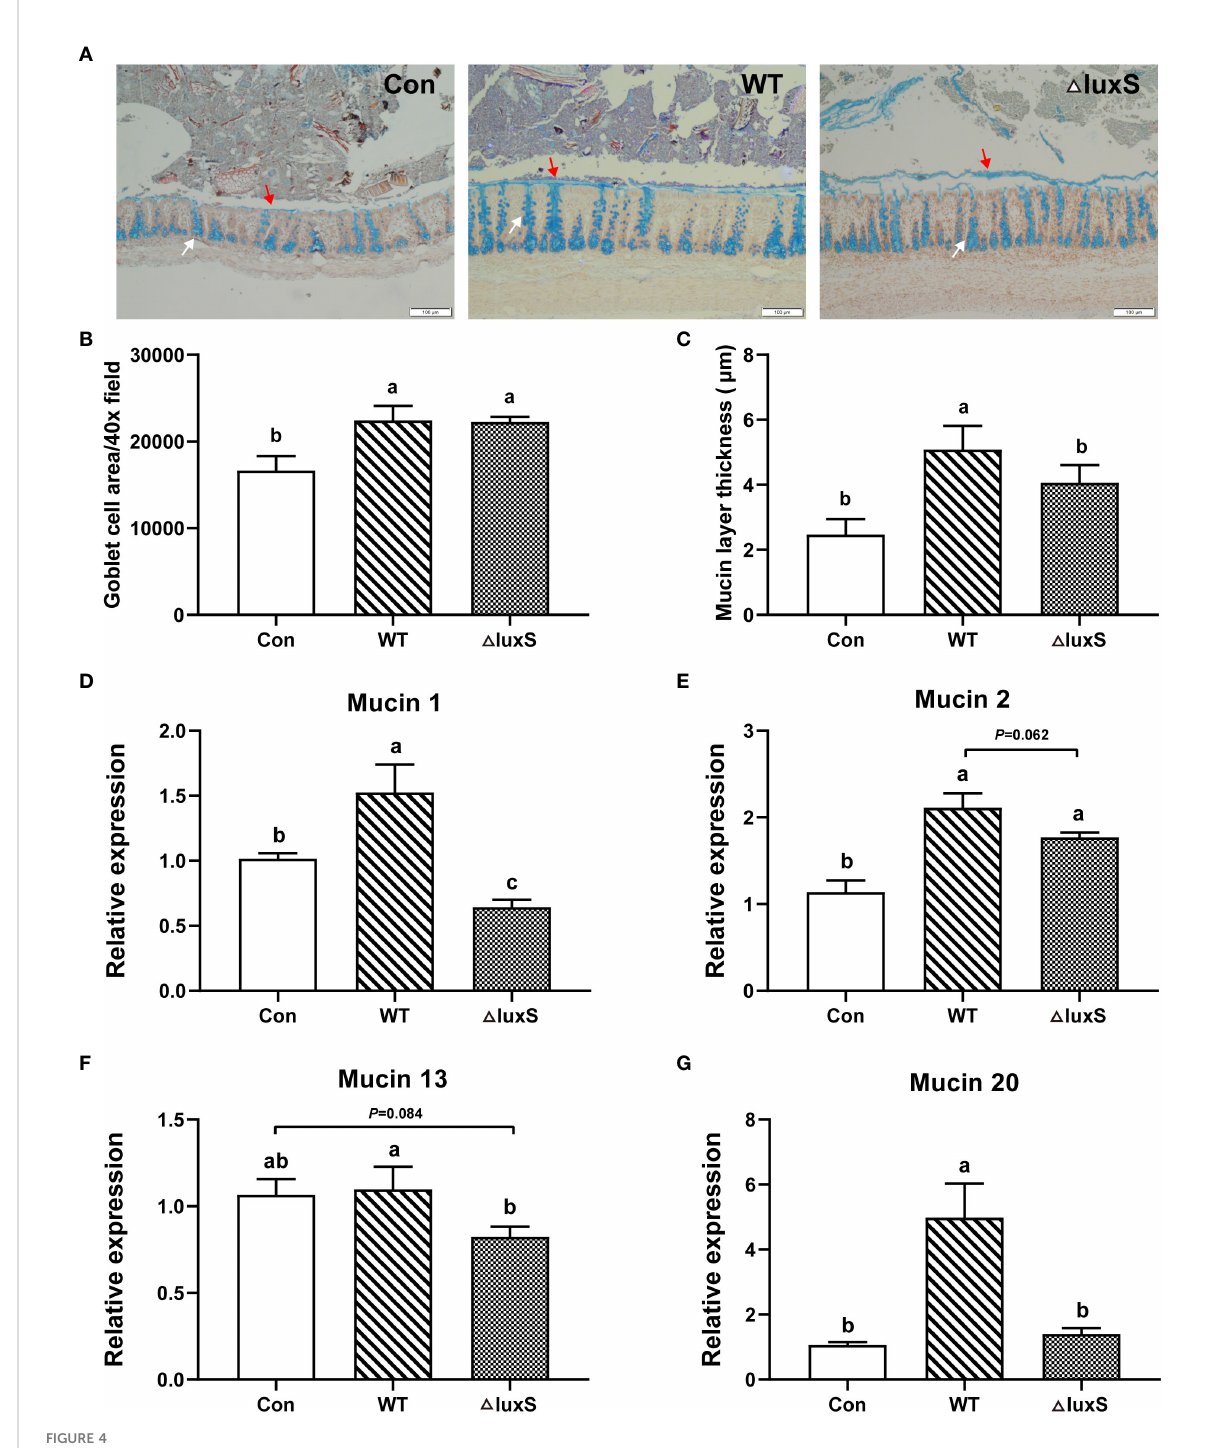
FIGURE 4 Intestinal chemical barrier functions in weaned piglets. (A) Alcian blue staining of colon (100 m m). (B) Goblet cell area. (C) Mucin layer thickness. Ten fi elds of view were randomly selected for each sample for statistics. Red arrows point to the mucus layer and white arrows point to goblet cells. (D-G) The relative mRNA expression of colonic mucins. GAPDH was used as an internal reference. Each PCR reaction was performed in three technical replicates across six biological replicates. WT and D luxS groups were orally inoculated with 2 mL of LGG wild strain and luxS mutant strain, respectively, for 3 weeks before weaning on day 21. Con group was orally inoculated with PBS. Statistical signi fi cance performed using one-way analysis of variance for multiple comparisons. Mean values not sharing common letters are signi fi cantly different ( P <0.05). Values are shown as mean ± SEM,